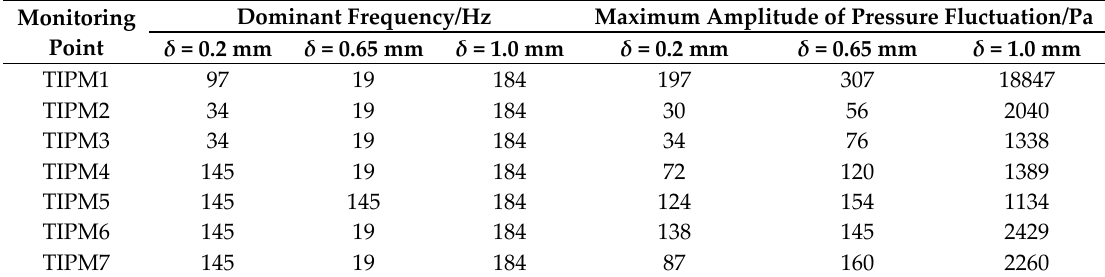
Table 5. Spectrum analysis of pressure fluctuations on